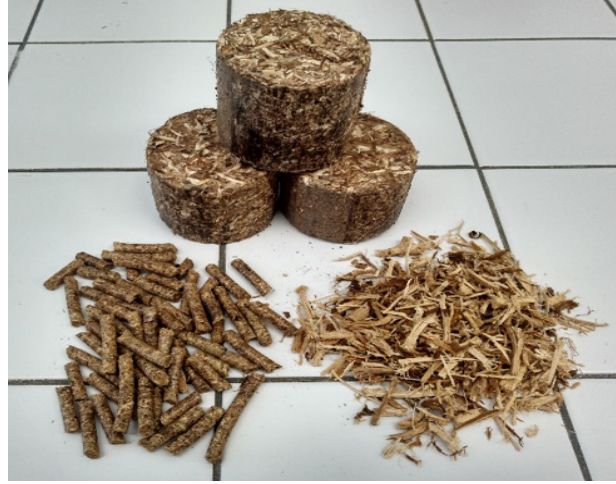
Figure 3. Initial material of apricot waste biomass and produced solid biofuels (pellets and briquettes).